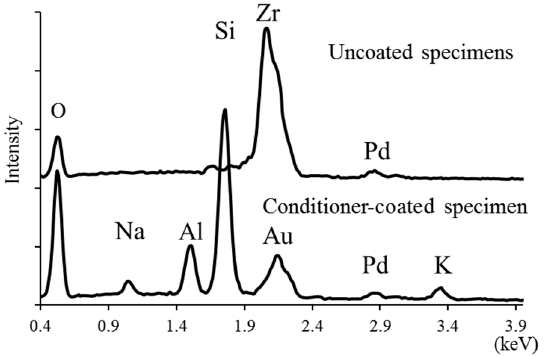
Figure 5. Energy dispersive X-ray spectroscopy (EDX) analyses of conditioner-coated and uncoated specimen surfaces.